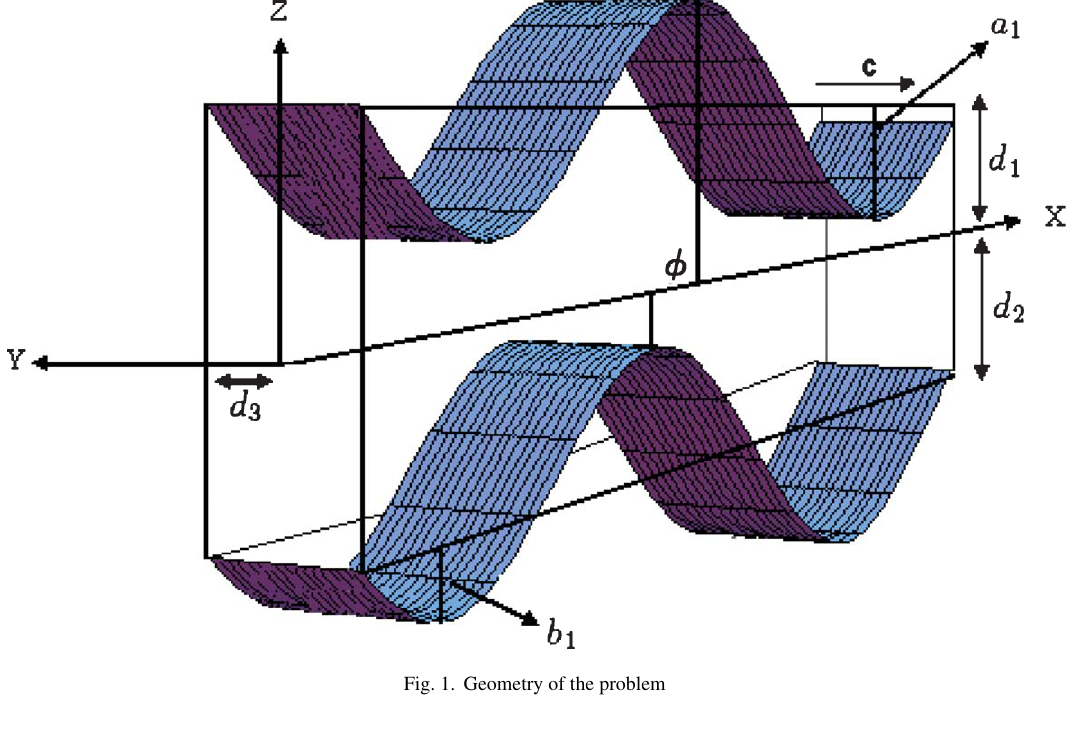
Fig. 1. Geometry of the